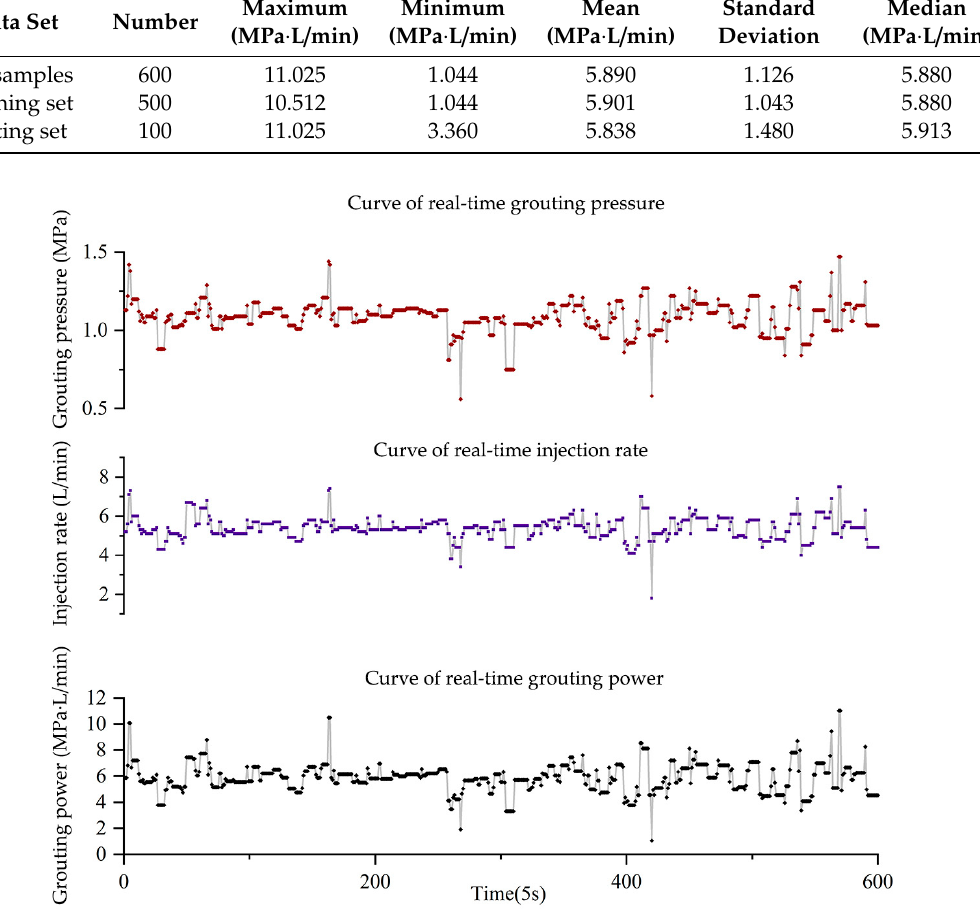
Figure 4. Original grouting power, grouting pressure, injection rate time series.